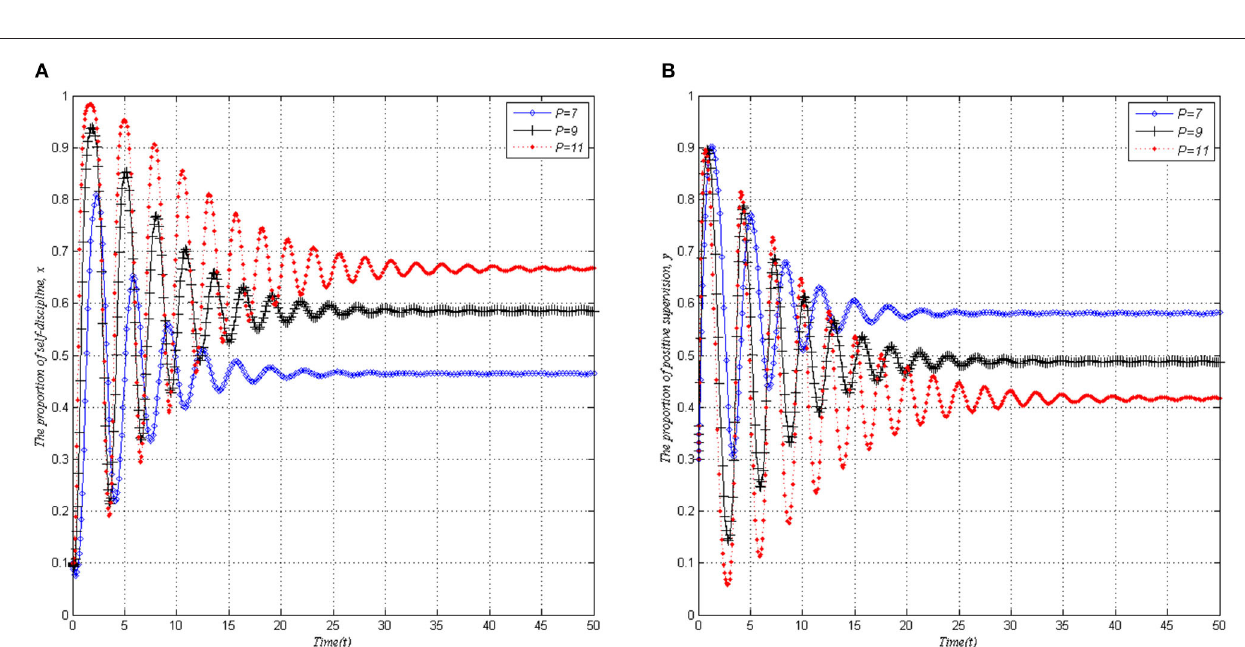
9, I 3, C 1, 1 L 4). (A) PHSIs. (B) Local governments. = = = =